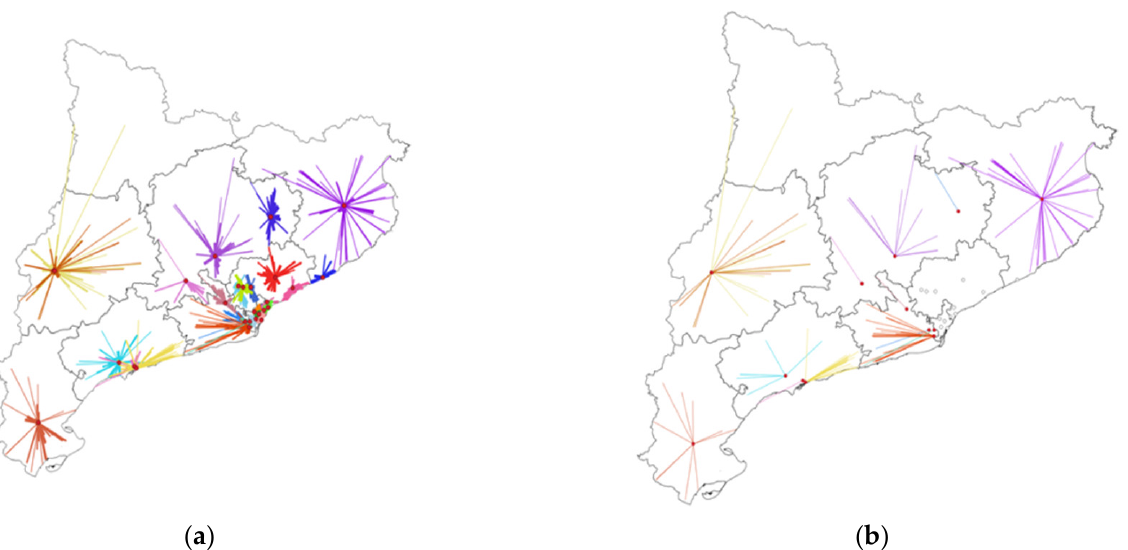
Figure 2. Distribution of pancreatic cancer cases according to locations of patients’ homes and surgical centers in Catalonia. ( a ) All cases of pancreatic cancer (N = 646). ( b ) Selection of cases with the longest distances (>90th%) between the patients’ homes and the reference centers (N = 64). Each color represents a different reference center.